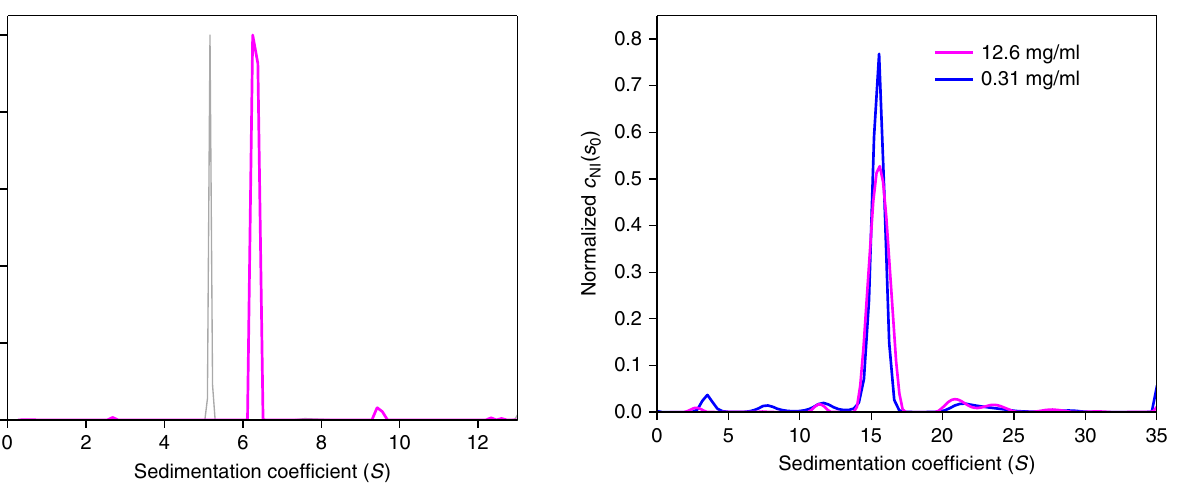
Fig. 3 Comparison of sedimentation coef fi cient distributions of apoferritin Fig. 2 Sedimentation coef fi cient distribution of NISTmAb. The nonideal samples under ideal and nonideal conditions. Sedimentation data from the c s fi t shown in Fig. 1 has a NI ( 0 ) model (magenta) associated with the nonideal 12.6 mg/ml sample in PBS were analyzed with the nonideal c NI ( s 0 ) monomer peak at 6.56 S, and a dimer peak comprising 2.7% of the material. model (magenta). Raw data and fi t are shown in Supplementary Fig. 4. The For comparison, the best- fi t standard c ( s ) model is shown as thin gray data from a dilute solution of apoferritin at 0.31 mg/ml (blue) were analyzed with the standard ideal c ( s ) model and providing best- fi t estimates of k S and k D of 18.4 (17.8 – 19.0)